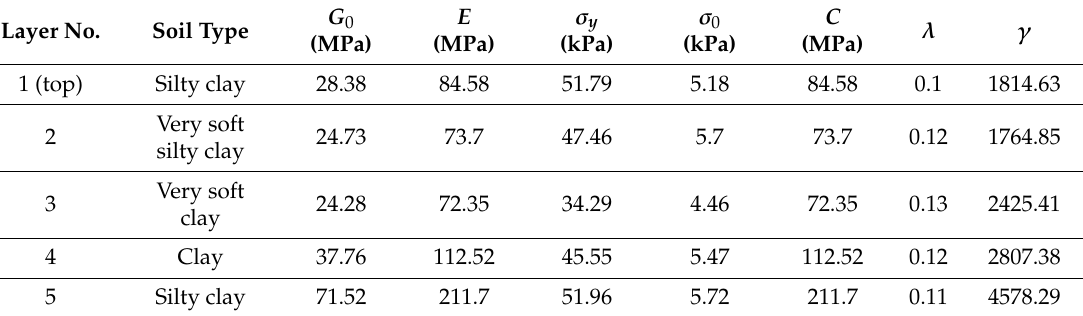
Table 1. Parameters of the constitutive